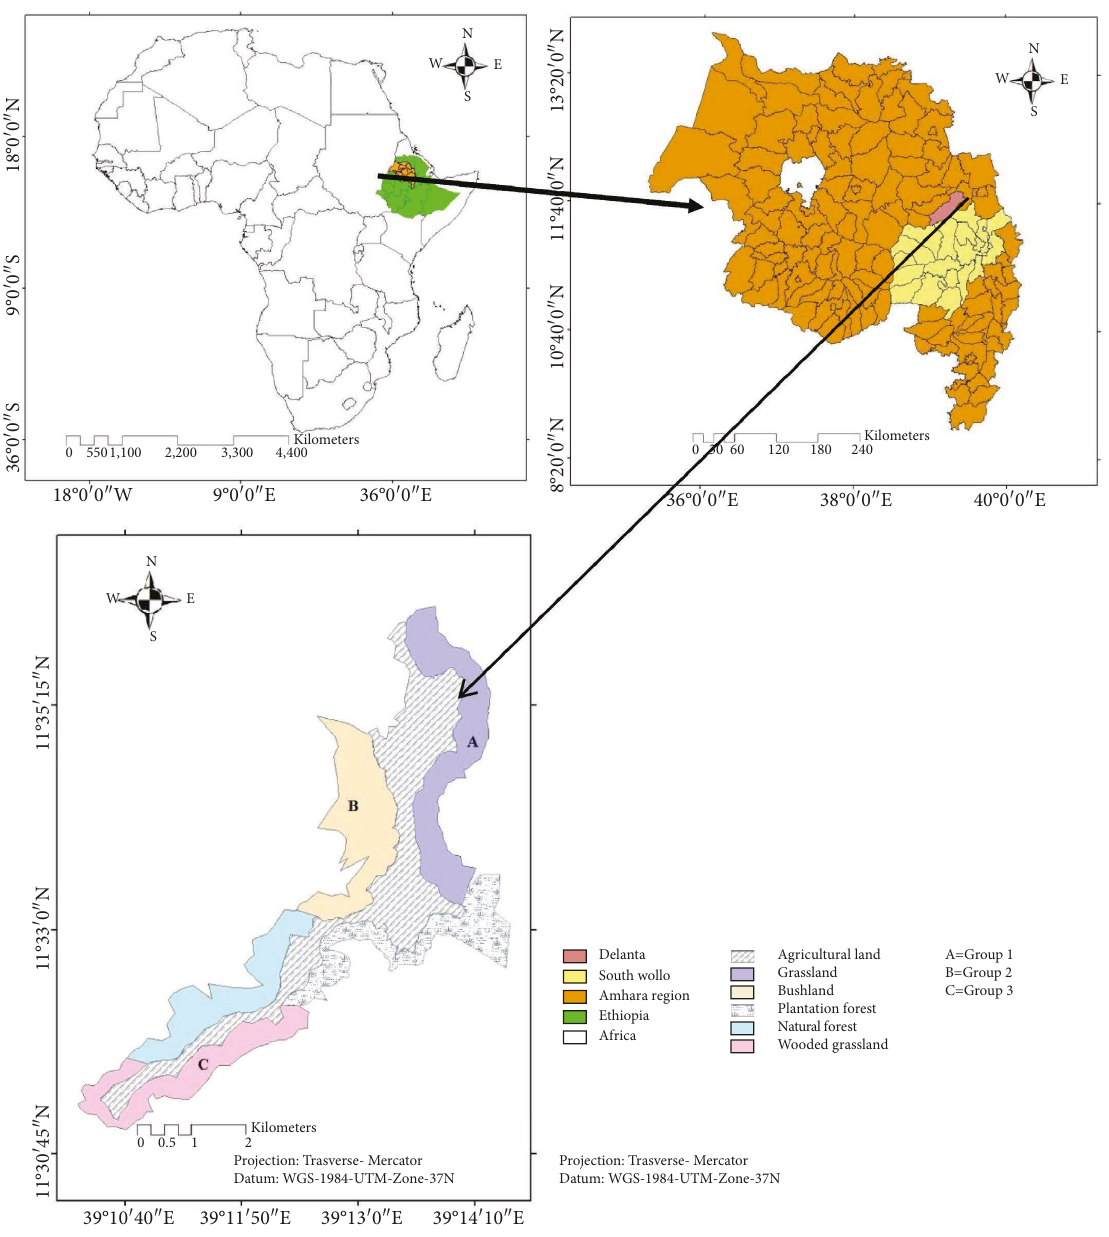
Figure 1: Location map of the study